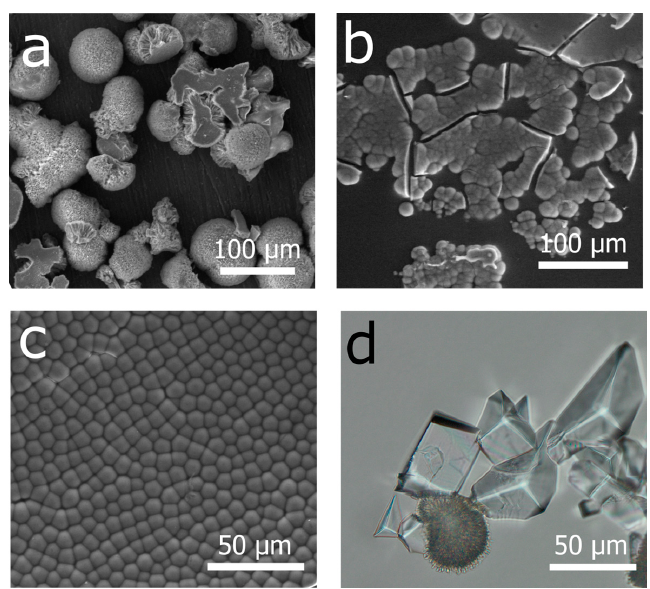
Figure 2. Particles precipitated at the air-water interface after 72 h. ( a ) SEM image of aragonite particles precipitated in the large desiccator; ( b ) SEM image of highly hydrated magnesium-substituted amorphous calcium carbonate precipitated in the medium desiccator; ( c ) SEM image of hexagonally-packed spherical highly hydrated magnesium-substituted amorphous calcium carbonate particles precipitated in the small desiccator; ( d ) Optical microscopy image of representative calcite and vaterite particles precipitated in the large desiccator after 72 h.